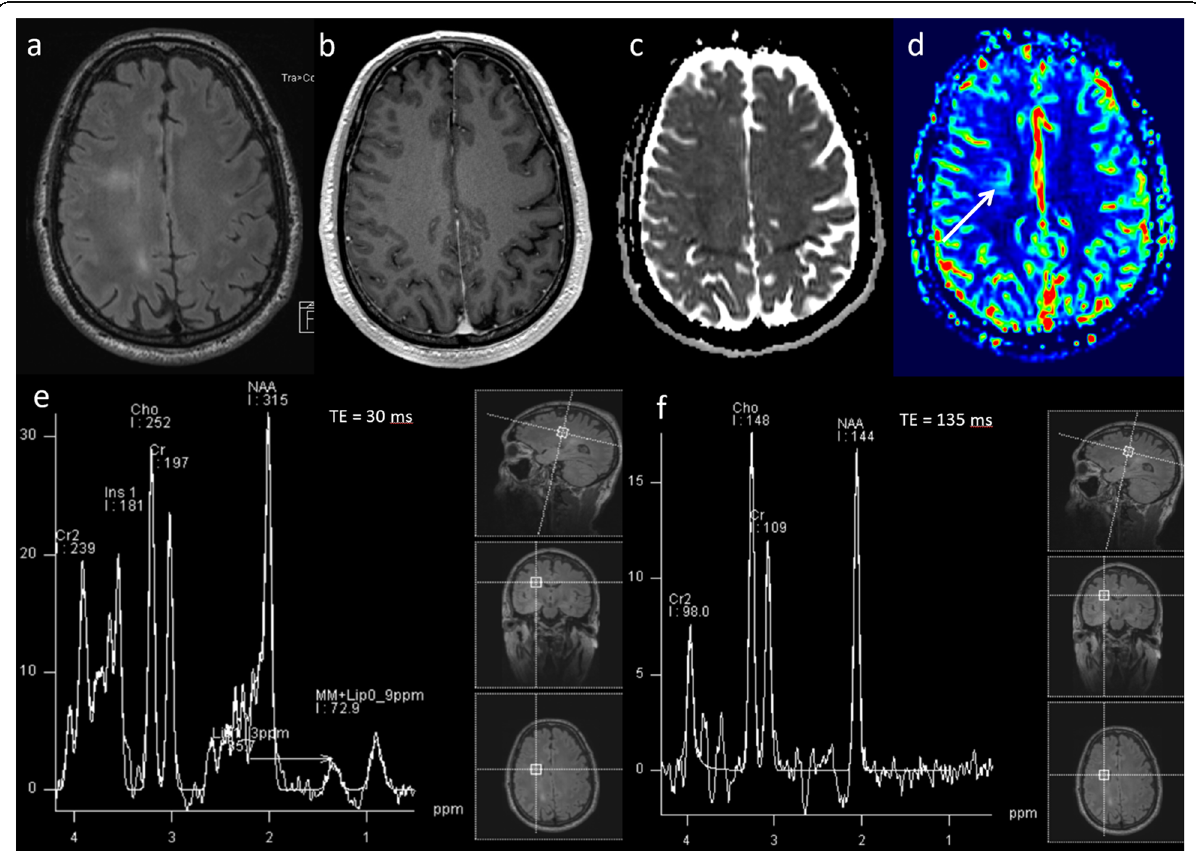
Fig. 7 Gliomatosis cerebri. Conventional MRI: a , b Axial FLAIR and post-contrast T1W sequences, showing diffuse infiltrative non-enhancing deep white matter lesion. Multiparametric MRI: c ADC map demonstrates no areas of low ADC. d However, PWI shows a focal area of slightly raised perfusion in the right frontal centrum semiovale (arrow) compared to normal-appearing white matter. e , f MRS shows high mI/Cr ratio, slightly raised Cho/Cr ratio (1.2) and slightly low NAA/Cr ratio. Focal raised perfusion and choline area was chosen for the optimal site of